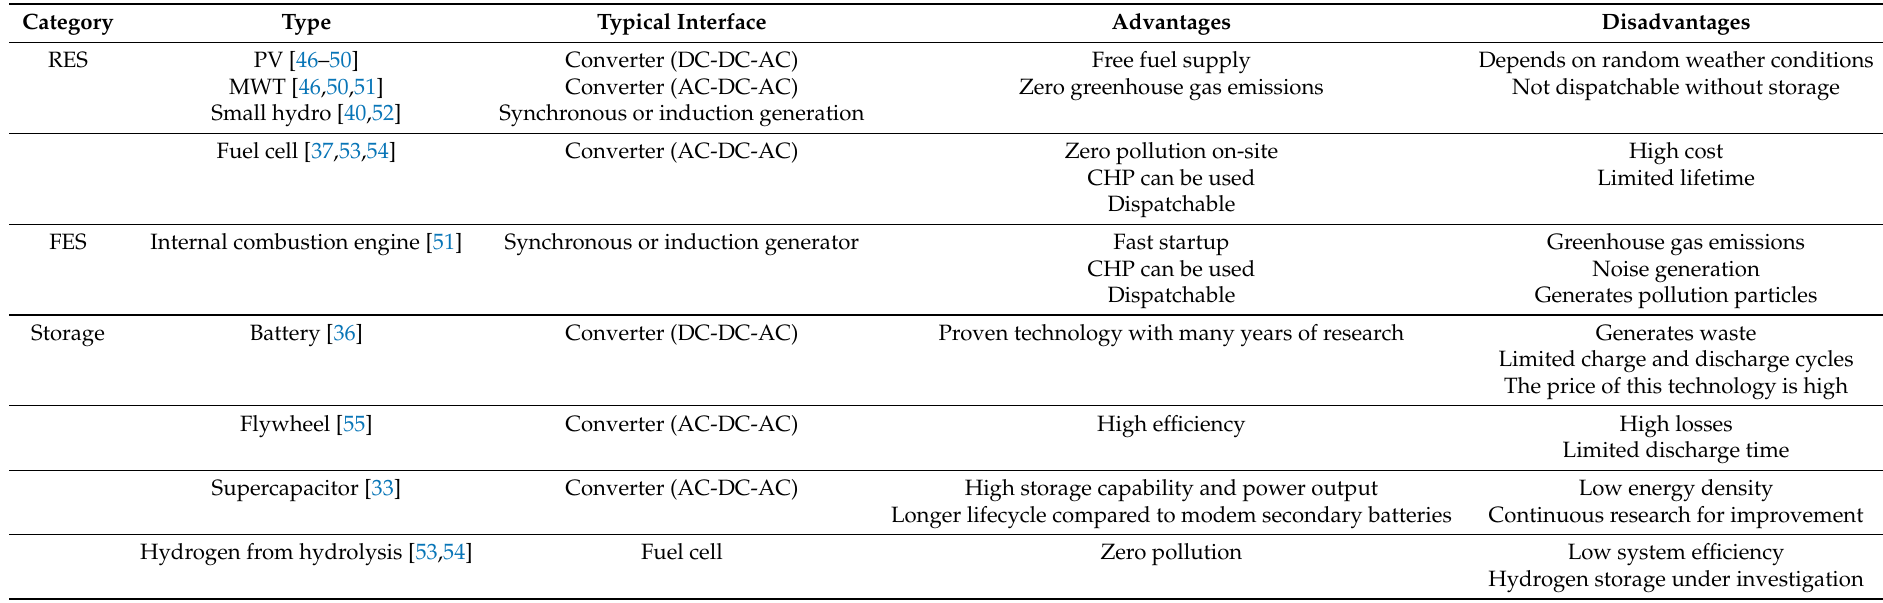
Table 1. Interface, advantages, and disadvantages of different MG